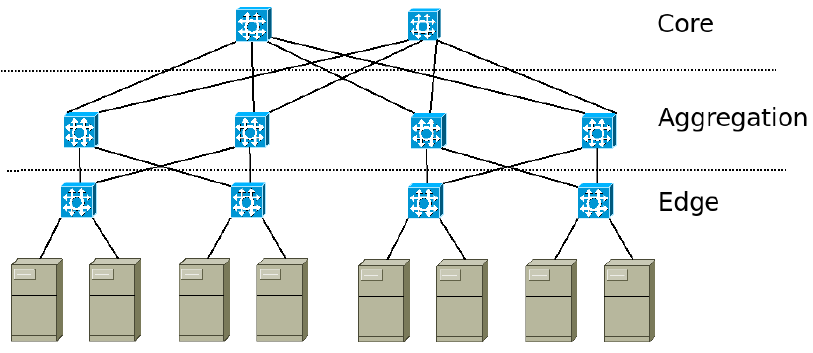
Figure 1. An eight-server fat-tree